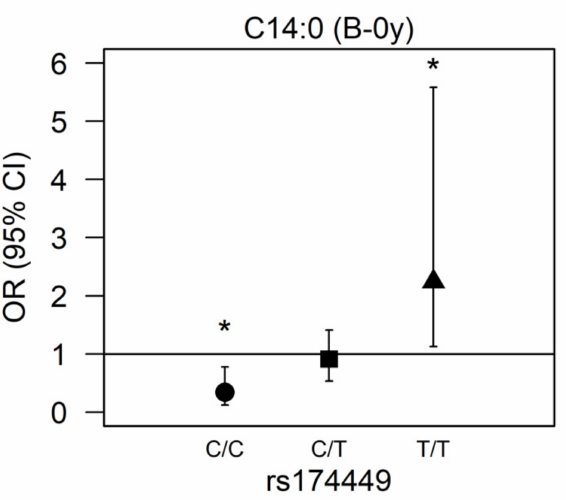
Figure 2. Association between myristic acid (C14:0) and AD modified by rs174449 genotype. B-0y: measured in buccal cells sampled at birth. * Nominal statistically significant ( p < 0.05). • : homozygous major genotype (C/C); (cid:4) : heterozygous genotype (C/T); (cid:78) : homozygous minor genotype